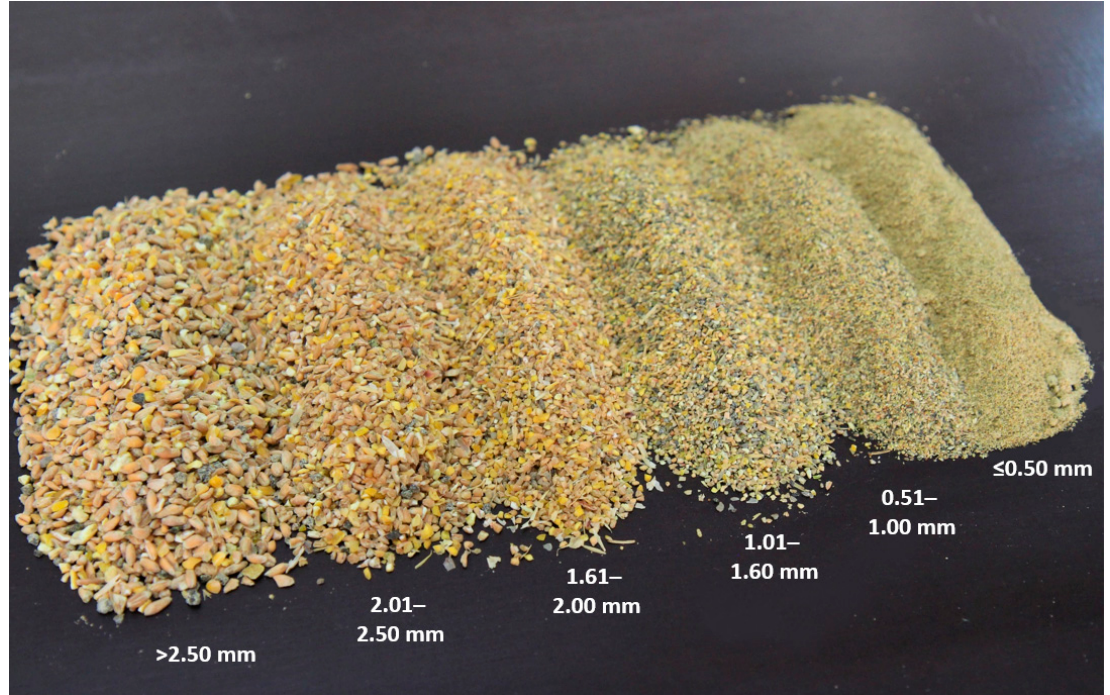
Figure 1. Feed particle fractions after a sieve analysis of a laying hen complete